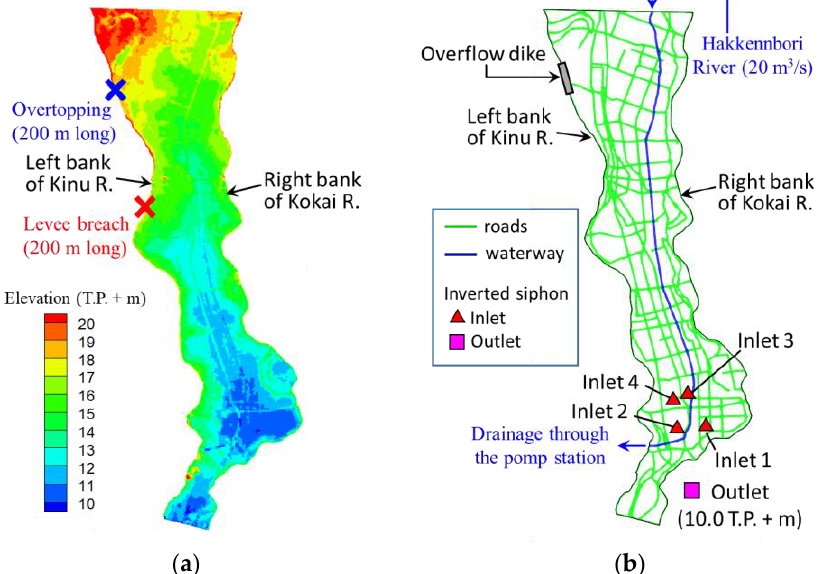
Figure 12. Model of topography; ( a ) ground elevation and ( b ) roads, irrigation channel, and inlet and outlet locations of inverted siphon.